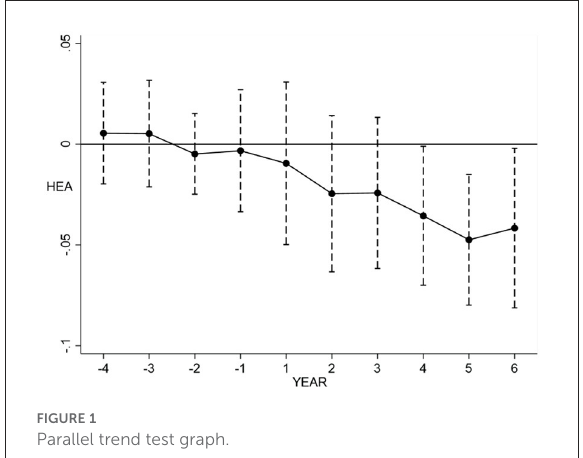
FIGURE1 Parallel trend test